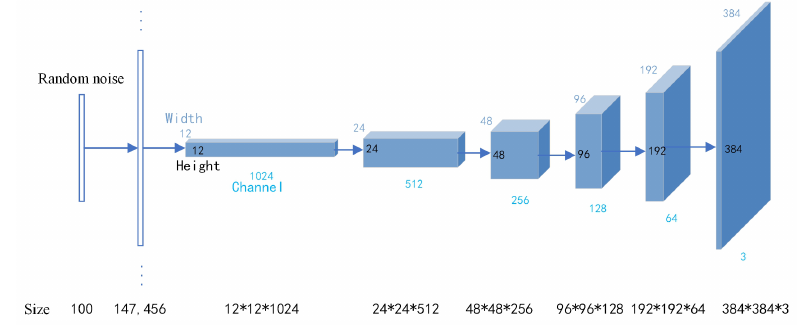
Figure 6. Generator structure.